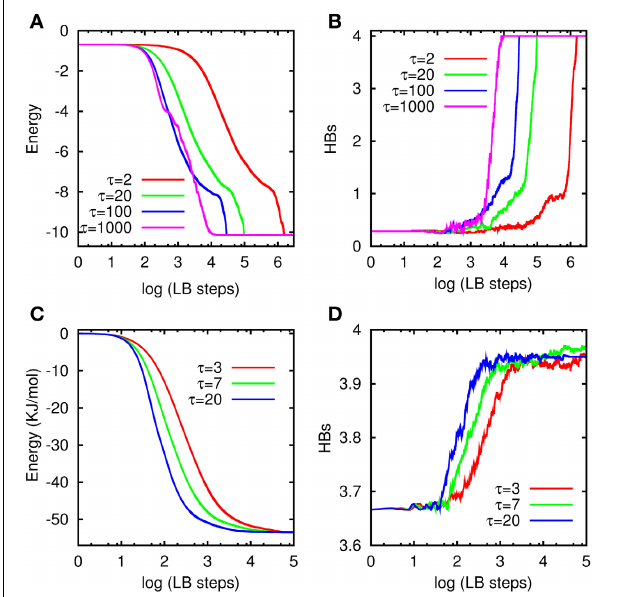
FIGURE 9 | The normalized HB angle distribution at different temperatures in the LTIP3P model with β − 1 ≡ k B T . In the inset the same distribution is presented using the data reported by Modig et al. [58].